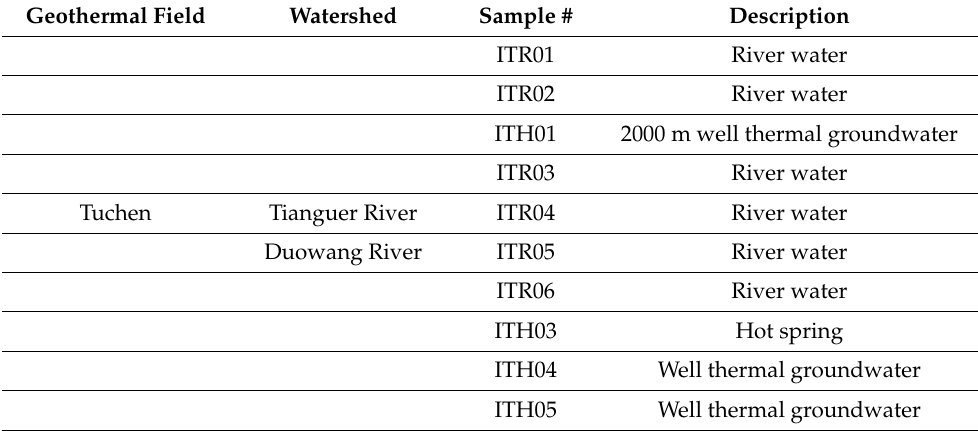
Figure 3. Sampling sites in the Tuchen geothermal field. The total 10 sampling sites in two tributaries, Tianguer river and Duowang river, of the study area. Surface water sampling sites are represented by green triangles and red ones represent well water. Table 1. Description of the characteristics of sampling sites of the study